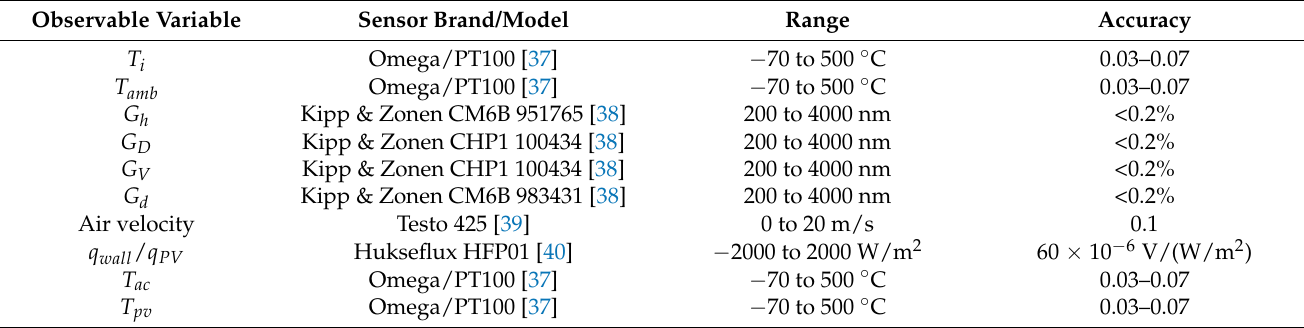
Table 2. Details of the measurement instruments [10].